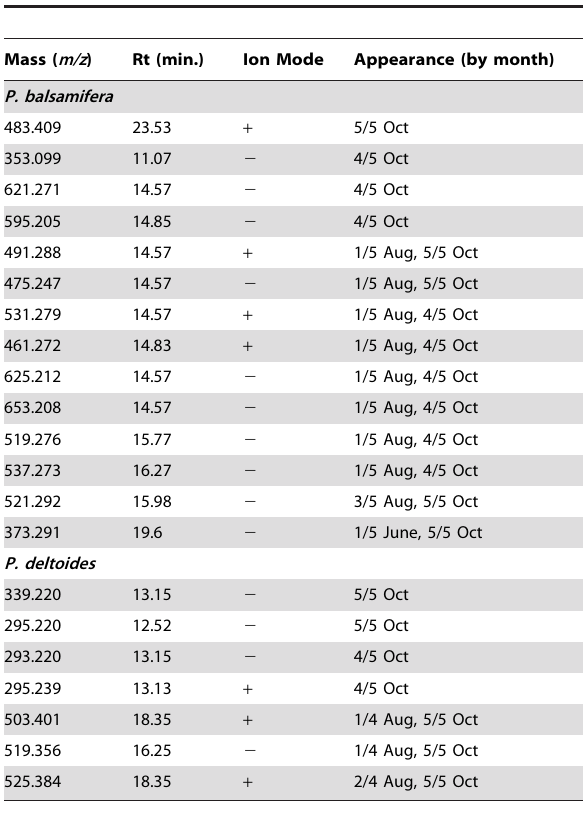
Table 2. Spectral peaks representing late-season indicators in P. balsamifera and P. deltoides .